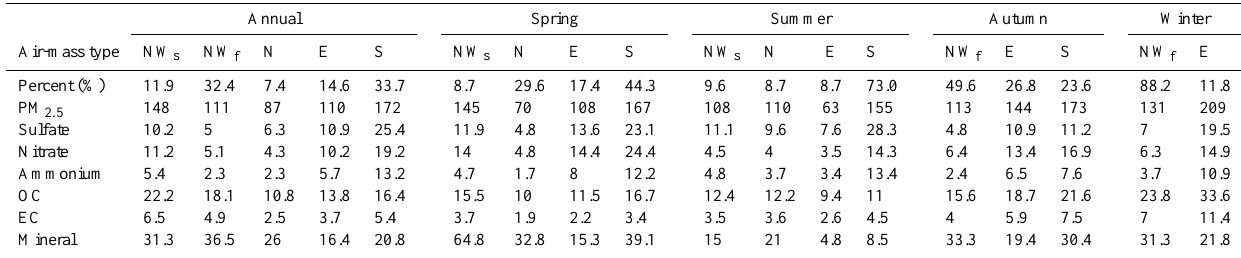
Table 3. Mean concentrations (in unit µgm − 3 ) of PM 2 . 5 and selected aerosol speciations in the identified trajectory clusters within the one-year (annual) and four-season period. Also given are the percentages of each trajectory cluster classified in the one-year and four-season periods. For details on trajectory clustering, please refer to the text. Annual Spring Summer Autumn